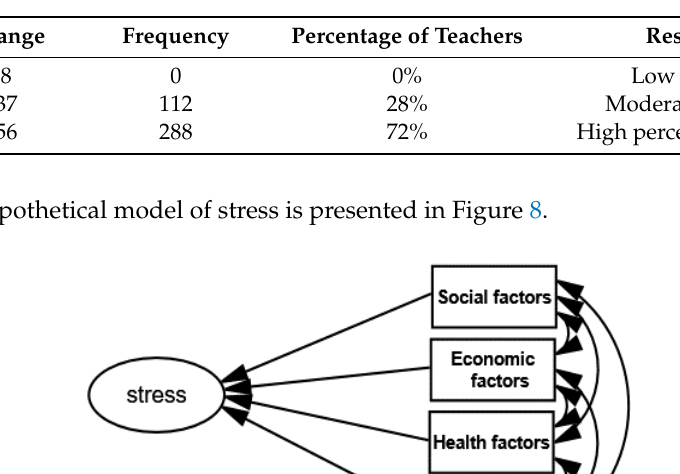
Figure 9. Hypothetical model of social factors. Figure 10. Hypothetical model of health factors.